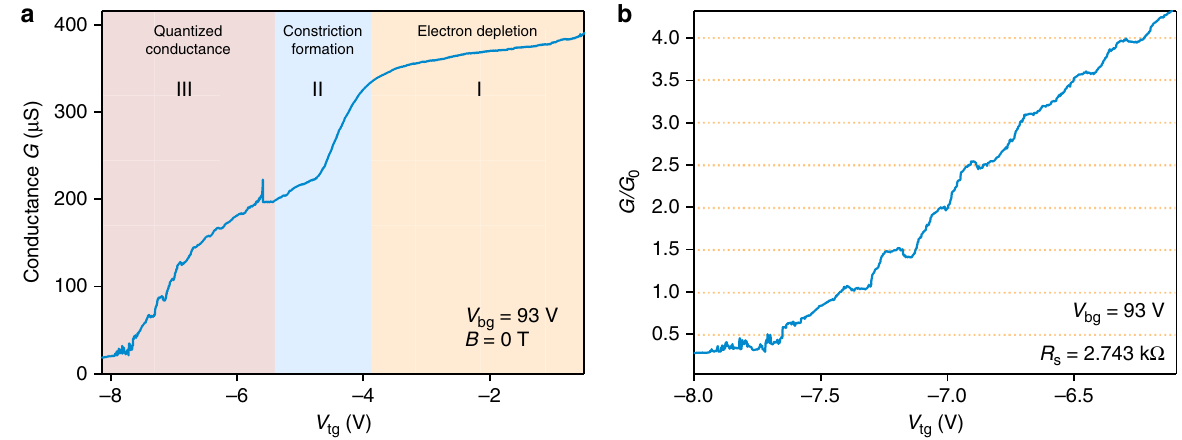
Fig. 3 Top-gate modulation of the conductance. a Raw data of the conductance modulation of the 1L-MoS 2 by the split gates at constant high doping induced by the back gate. Three distinguishable regions in the curve correspond to electron depletion under the top gates (I), the formation of a constriction (II) and fi nally, stepwise turn-off of the device (III). b Conductance steps occurring at half and full values of G 0 = 2 e 2 / h after subtraction of a series resistance R s = 2.74 k Ω , indicating the lifting of spin degeneracy due to conduction band